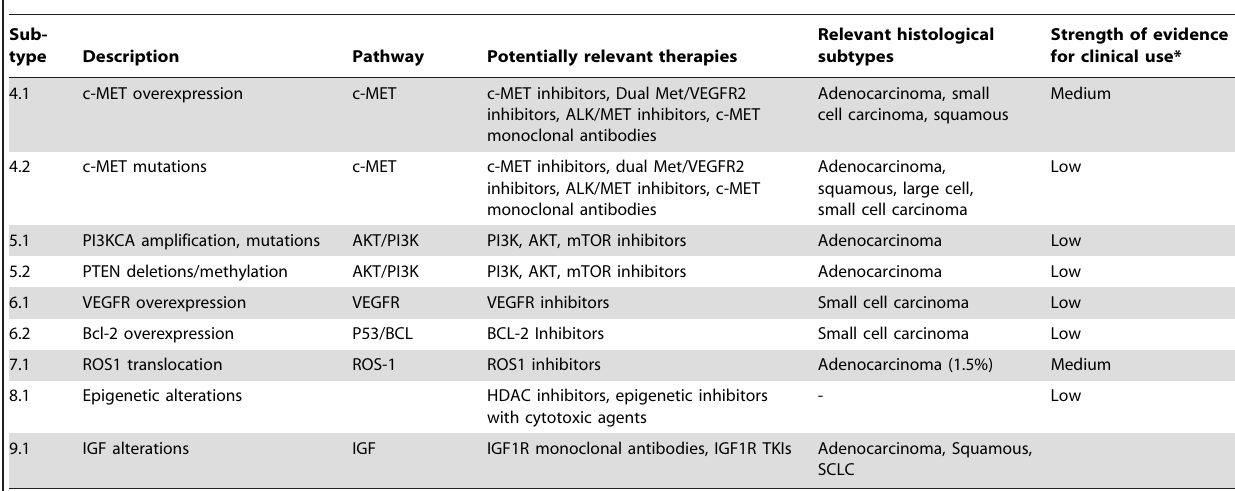
Table 2. Secondary lung cancer molecular